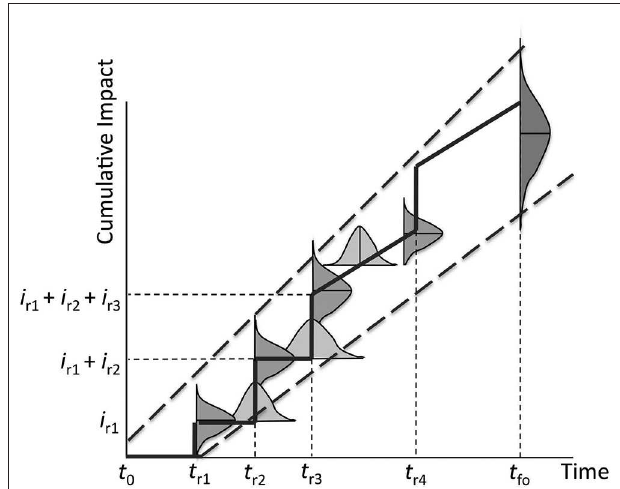
FIGURE 1 | Probabilistic envelope of cumulative impacts of repairs and rehabilitations of civil infrastructure from initial construction ( t 0 ) to functional obsolescence ( t fo ) ( Lepech et al.,